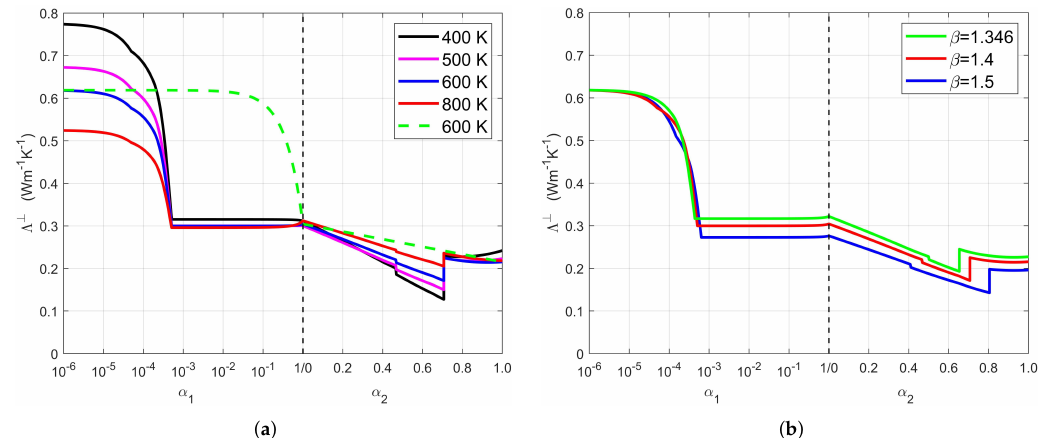
Figure 13. The effective conductivity Λ ⊥ as functions of the ATH dehydration ( α 1 ) and EVA decomposition ( α 2 ) advancements, at various temperatures with β = 1.4 ( a ), and at T = 600 K with various intumescence factors ( b ). The scale is logarithmic for α 1 and linear for α 2 . The green broken line in ( a ) corresponds to a linear interpolation between states [S0], [S1] and [S2], when T = 600